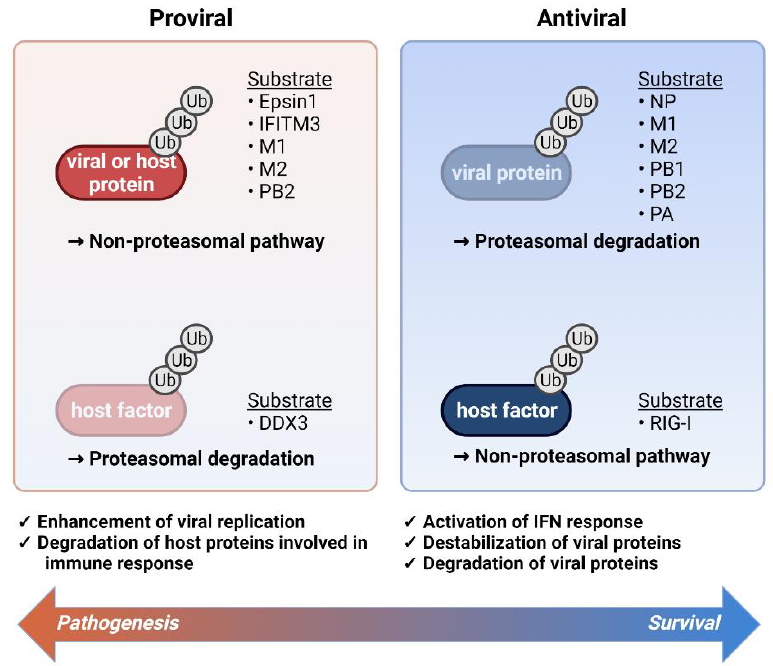
Figure 1. The role of ubiquitination during influenza virus infection. A balance between enhancement and inhibition of viral replication determines the final pathological outcomes of the viral infection. The main viral components are ubiquitinated for proteasomal degradation and RIG-I ubiquitination contributes to the induction of IFN response ( right panel ). On the other hand, host or viral proteins are subjected to the ubiquitination to engage in proviral activity and in parallel, antiviral regulators such as DDX3 ubiquitination suppress immune activation ( right panel ). The viral and host proteins that are targeted by ubiquitination are listed in the right (antiviral) and left (proviral) side of the figure.